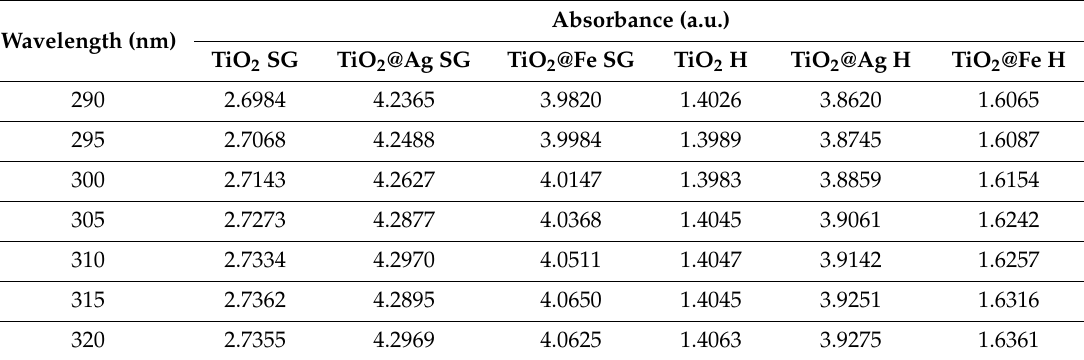
Table 2. The absorbance of the samples according to the wavelength.